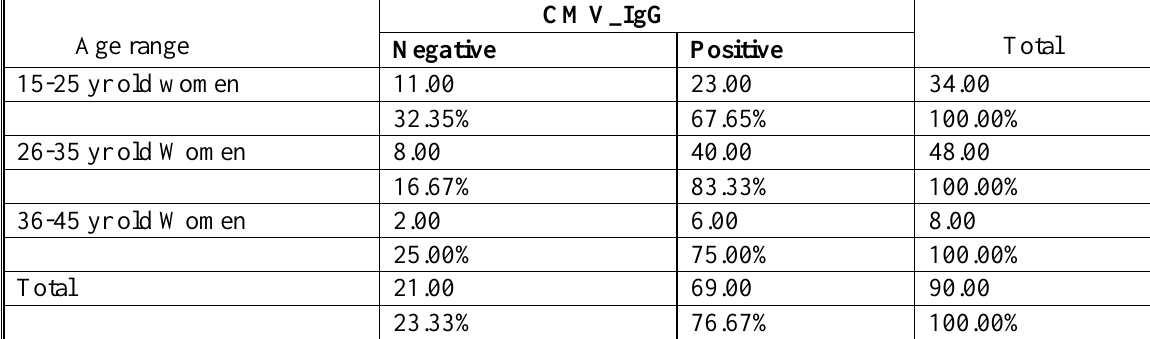
Table 2. Prevalence of CMV IgG among different age groups